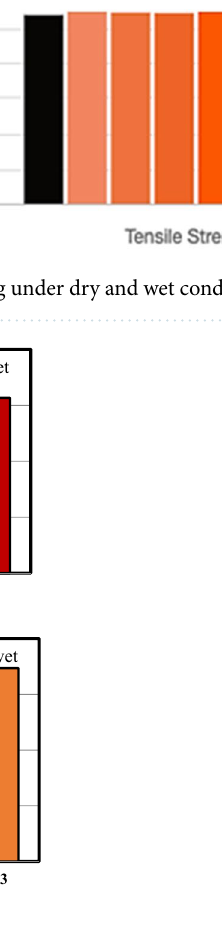
Figure 6. The tensile strain of multilayers epoxy coating to steel substrate filled with ( a ) Al 2 O 3 microparticles ( b ) Al 2 O 3